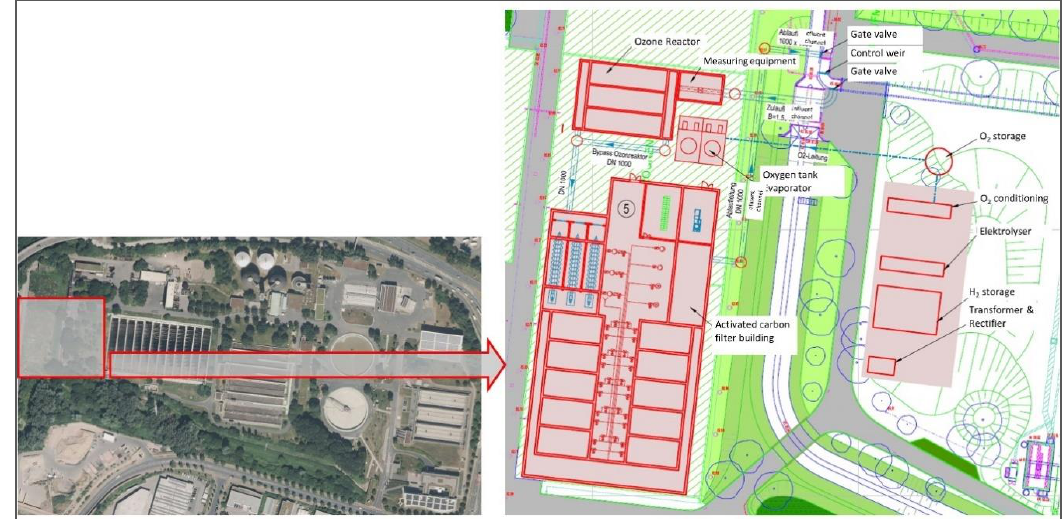
Figure 5. Aerial view of WWTP Mainz (www.geoportal.rlp.de; “Data license Germany—attribution— Version 2.0” referring to the license text available at www.govdata.de/dl-de/by-2-0; left side) and extract of a side plan with the new system components (right side) [41].